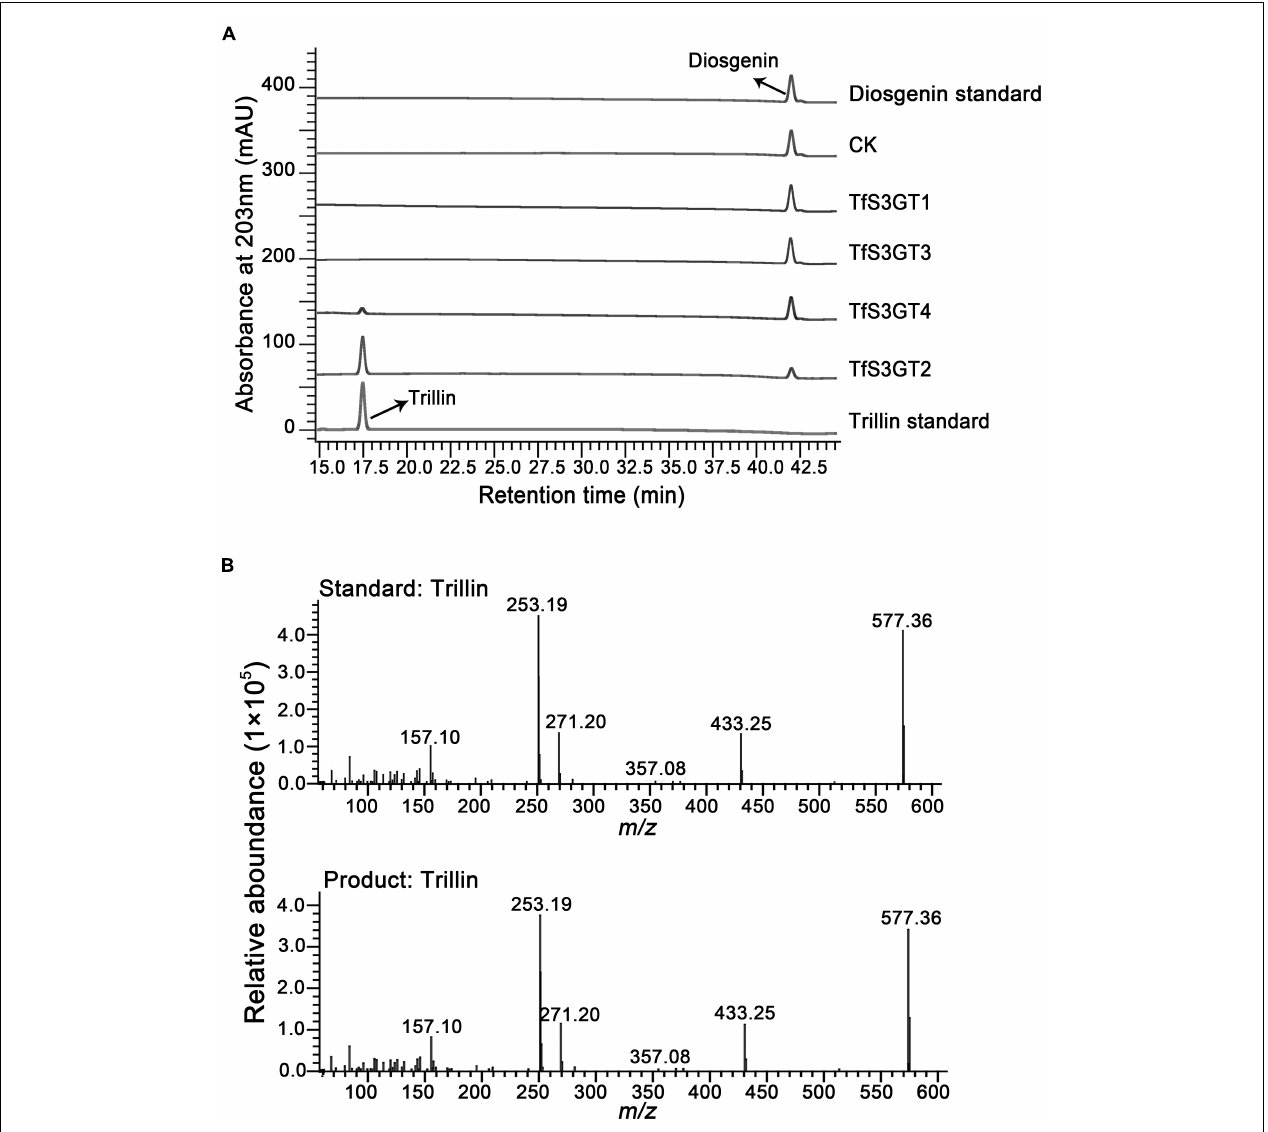
FIGURE 3 | HPLC analysis of the products extracted from the in vivo assays of TfS3GT2 or TfS3GT4 with diosgenin (A) . The mass spectrum of the trillin product in comparison with the trillin standard (B)